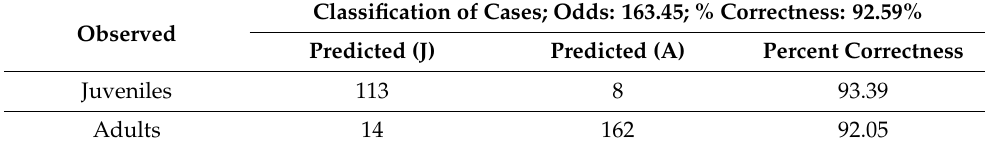
Table 3. Classification of cases in the logistic model in relation to body weight. Classification of Cases; Odds: 163.45; % Correctness: Observed